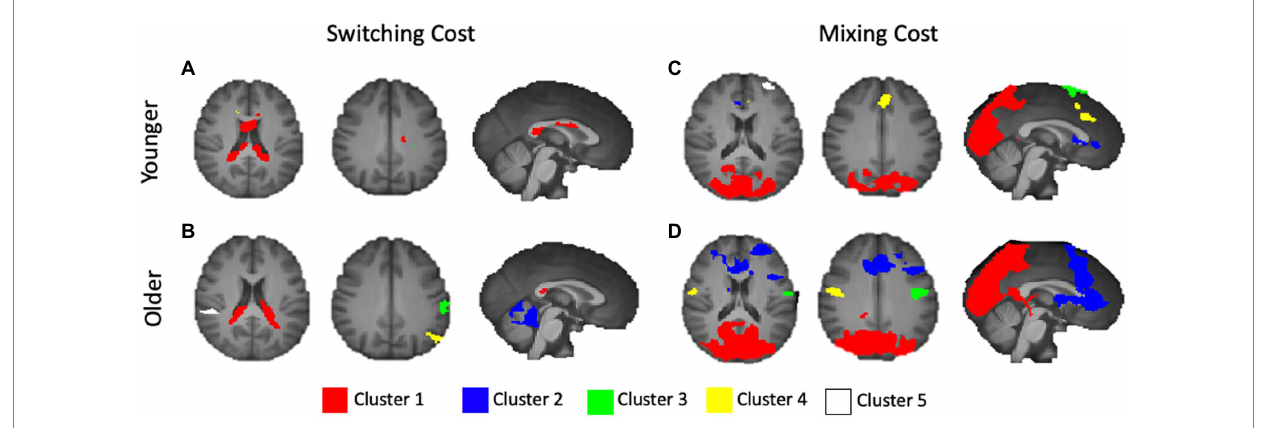
FIGURE 3 Activations for younger and older adults, separately, for switching and mixing costs. (A) Younger Switching Cost; (B) Older Switching Cost; (C) Younger Mixing Cost; and (D) Older Mixing Cost. Only the five largest clusters for each contrast are rendered. Details of each cluster are shown in Table 1, with colors representing separate clusters according to size: Cluster 1 = Red, Cluster 2 = Blue, Cluster 3 = Green, Cluster 4 = Yellow, Cluster 5 =